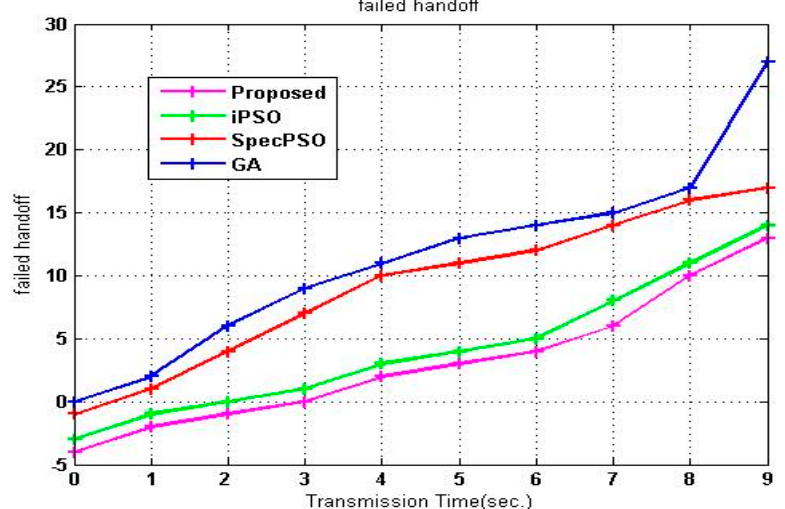
Figure 8. Failed handoff vs. transmission time.